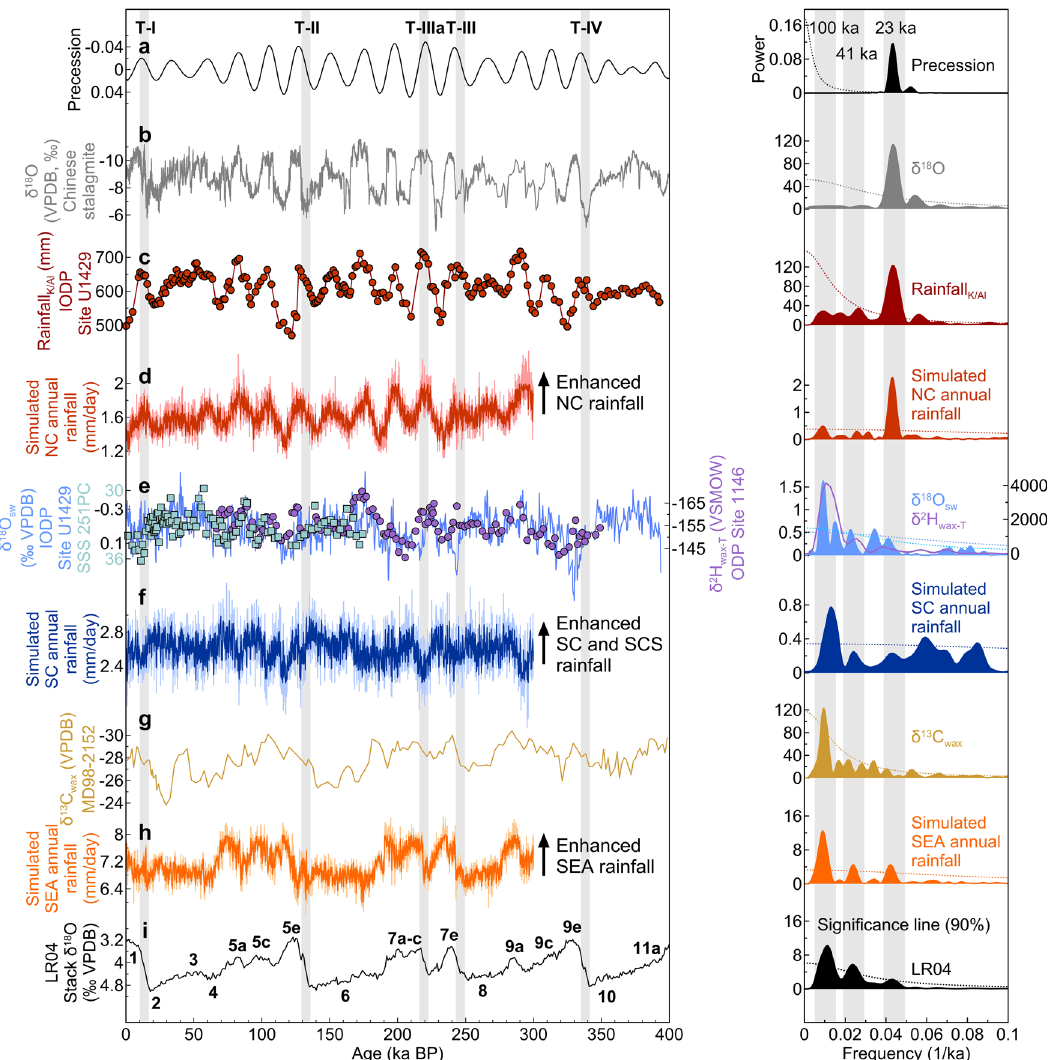
Fig. 2 Reconstructed and simulated East-Southeast Asian hydroclimate conditions and comparison with precession and benthic foraminiferal δ 18 O records (left), as well as their corresponding spectral analysis results (right). a Precession 87 . b Chinese stalagmite δ 18 O record 44 . c Rainfall K/Al record at IODP Site U1429 indicates the rainfall in northern China (this study). d Simulated rainfall in northern China (this study, box NC in Fig. 1b). e The δ 18 O sw record obtained at IODP Site U1429 11 , the rainfall δ 2 H record at ODP Site 1146 12 (marked by circles), and the SSS record of core 251PC in the eastern South China Sea 53 (marked by rectangles). All of them indicate the rainfall in southern China and the South China Sea. f Simulated rainfall in southern China (this study, box SC in Fig. 1b). g δ 13 C wax record MD98-2152 from southern Sumatra 17 indicate the rainfall in the western regions of Southeast Asia. h Simulated Southeast Asian rainfall (this study, box SEA in Fig. 1b). i LR04 stacked benthic δ 18 O curve 72 . Spectral analysis has been performed with PAST software; 88 the window function is rectangle. The gray vertical bars mark the timing of glacial terminations and orbital periodicities, as shown in the left and right panels,